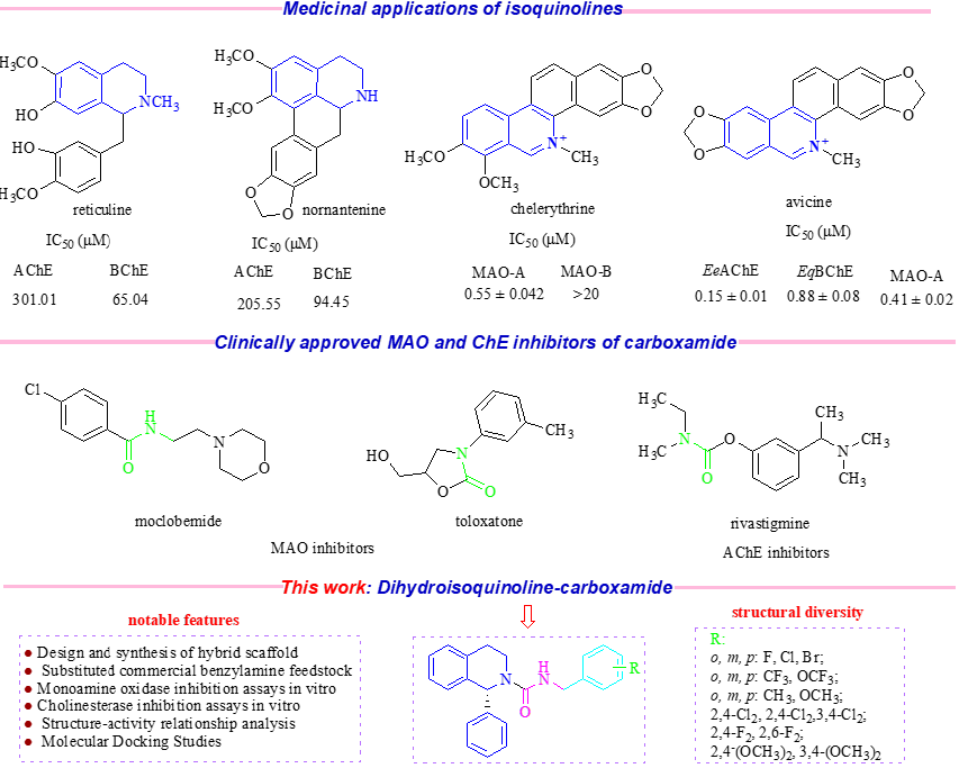
Figure 1. Examples of marketed drugs used for the treatment of AD and depression, and SAR generation around Isoquinolines. Recently, our research group has reported the preparation of a series of 3,4-dihy- droisquinoline-2(1H)-carboxamide analogs as candidate antidepressant agents. The com-